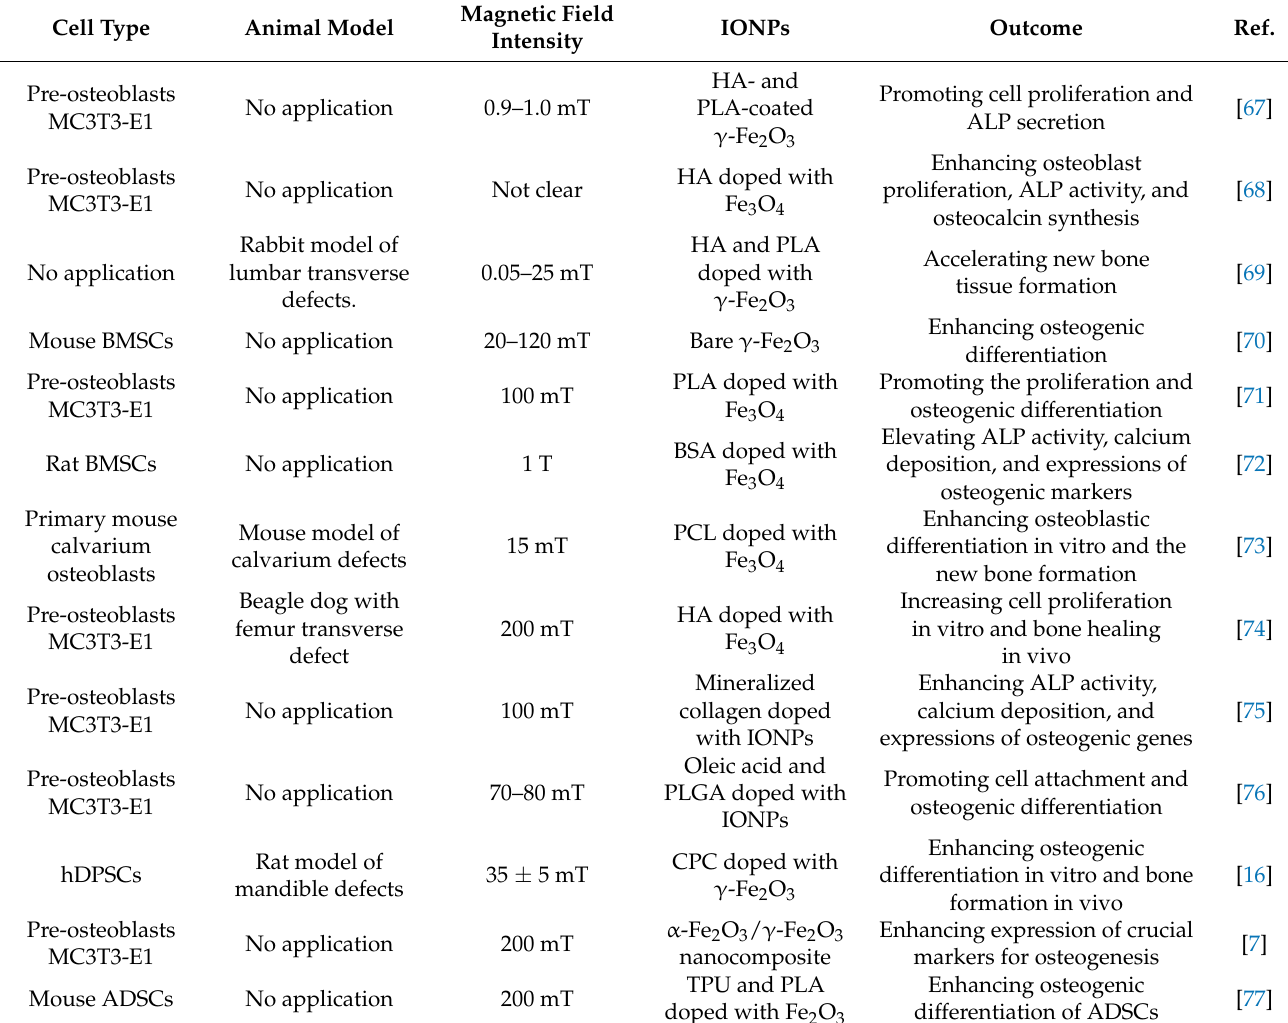
Table 1. Effects of iron oxide nanoparticles combined with static magnetic fields on bone